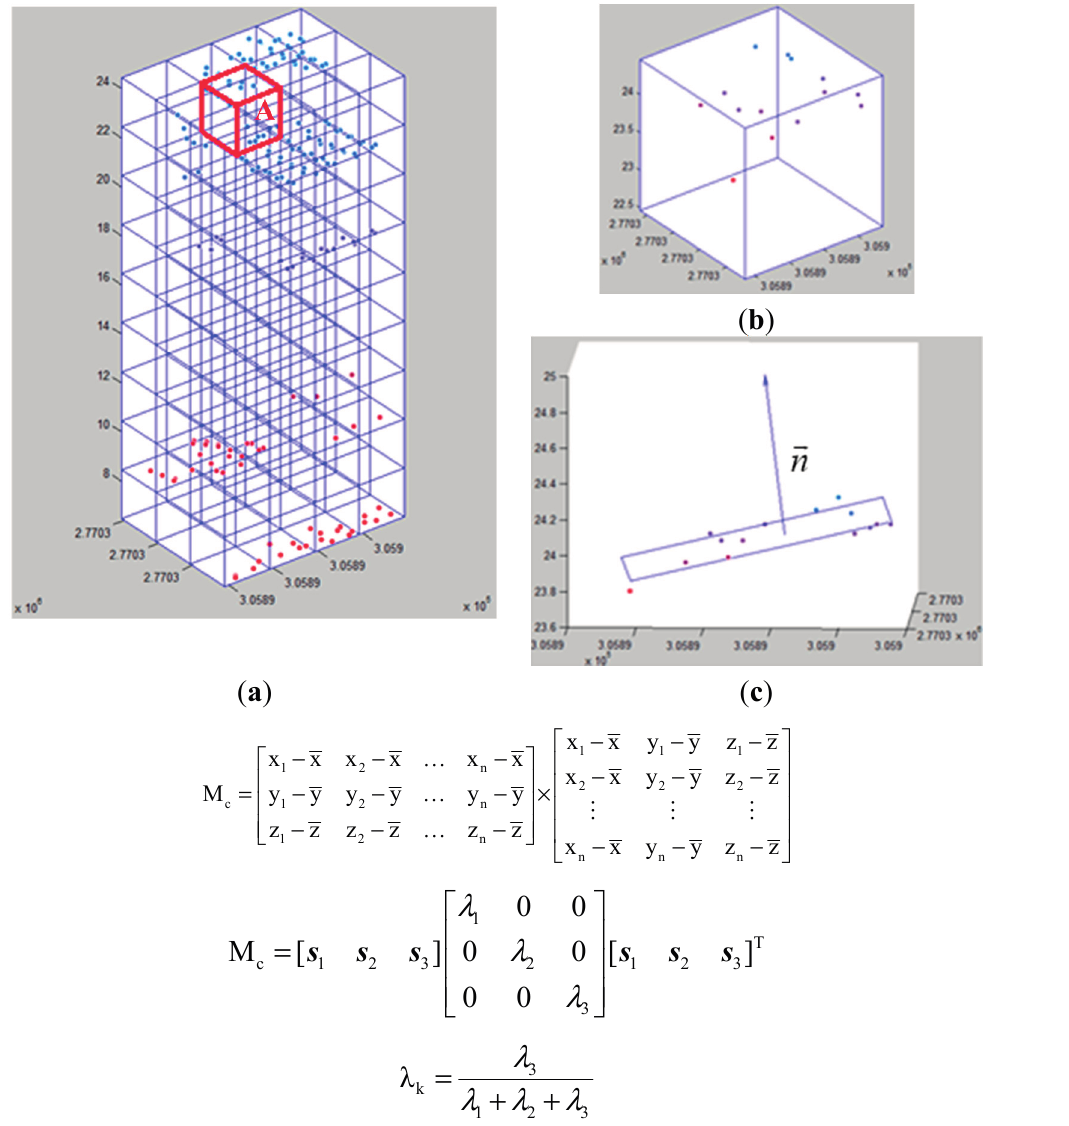
Figure 2. Illustration of points to normal vectors: ( a ) voxels, ( b ) points in voxels A, ( c ) normal vector of plane in voxel